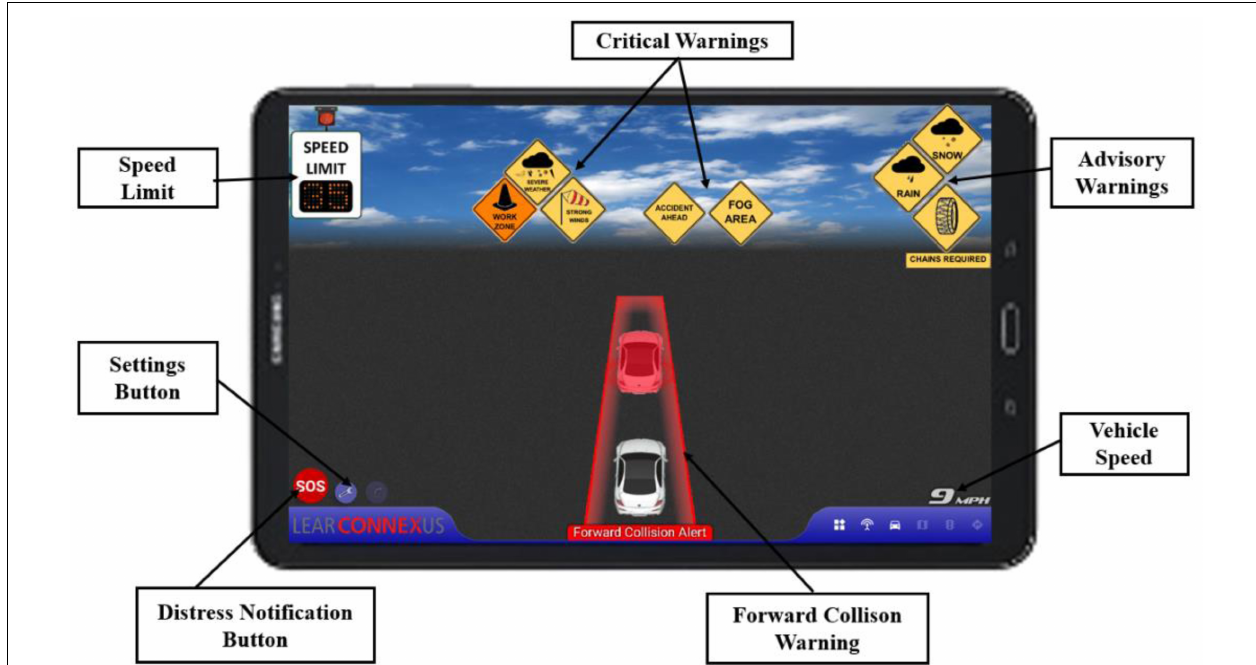
FIGURE 1 | Layout of the Wyoming CV HMI (Ahmed et al., 2019b).